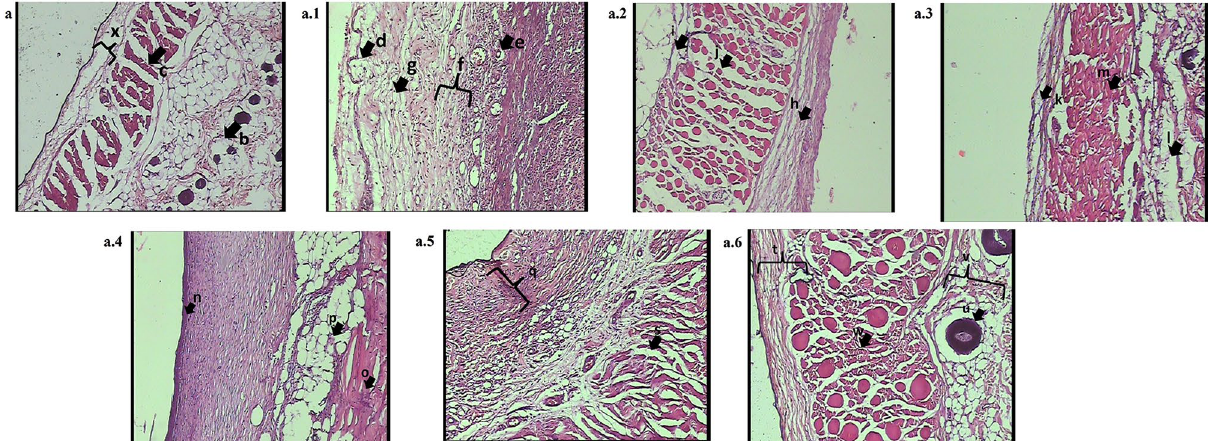
Figure 7. Burn wound histopathological assessment on day 21: Standard morphology of the epidermis, dermis and hypodermis was found during photomicrographs of a histopathological examination of the Normal group ( a ). The Control group ( a.1 ) was observed to have marked characteristics of burn crust development in the dermis and epidermis, extreme leukocyte aggregation, congestion of the blood vessels, hair follicles, and the sebaceous glands. Moderate leukocytes, blood vessel destruction, and degenerating degeneration of hair follicles and sebaceous glands were observed in the topical application of the Cream and the GbH (Hydrogel) placebo group ( a.2 ) and ( a.3 ). The quercetin drug-treated cream and the GbH group (QC, QH) and silver sulfadiazine (SS) ( a.4 ), ( a.5 ) and ( a.6 ) displayed no symptoms of leukocyte accumulation, favoured by epithelium regeneration. The restored skin architecture refelects the regeneration of the epidermis upon the topical application of quercetin loaded GbH, which is in accordance with normal